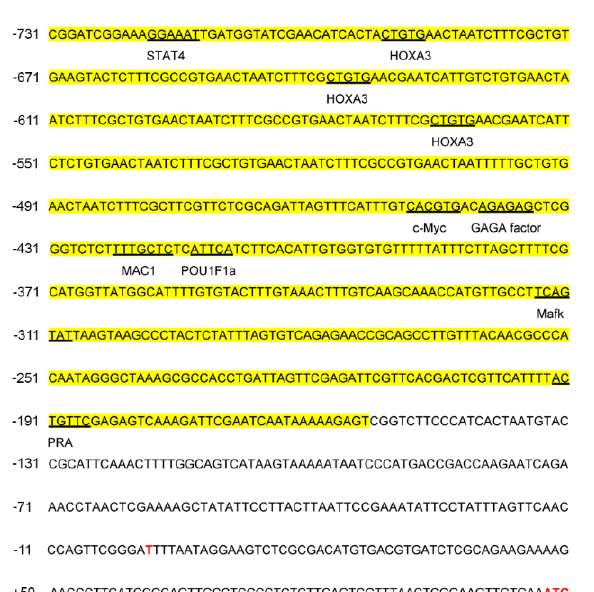
Figure 5. Fluorescence activity of different fragment lengths in the promoter region of Cs-ewsr1-w gene. The left panel exhibited the schematic map of promoter fragments with different deletion regions. The right panel showed the luciferase activities of the promoter fragments with different deletions. Different letters represent significant differences among species ( p < 0.05).